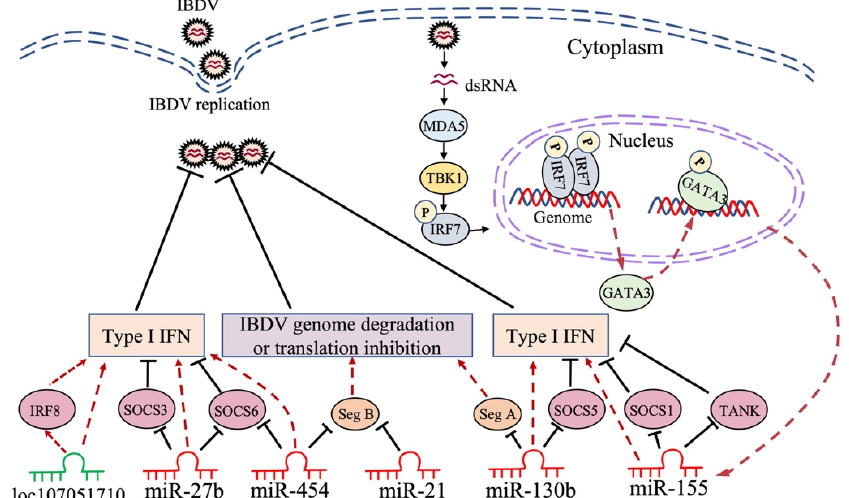
Figure 2. Schematic diagram of the roles of non-coding RNA in host response to IBDV infec- tion. IBDV infection affects the expression of non-coding RNAs in host cells. Non-coding RNAs play roles in inhibiting IBDV replication by directly targeting the viral genome or host gene in- volved in immune signaling pathways. Seg A: IBDV genome segment A; Seg B: IBDV